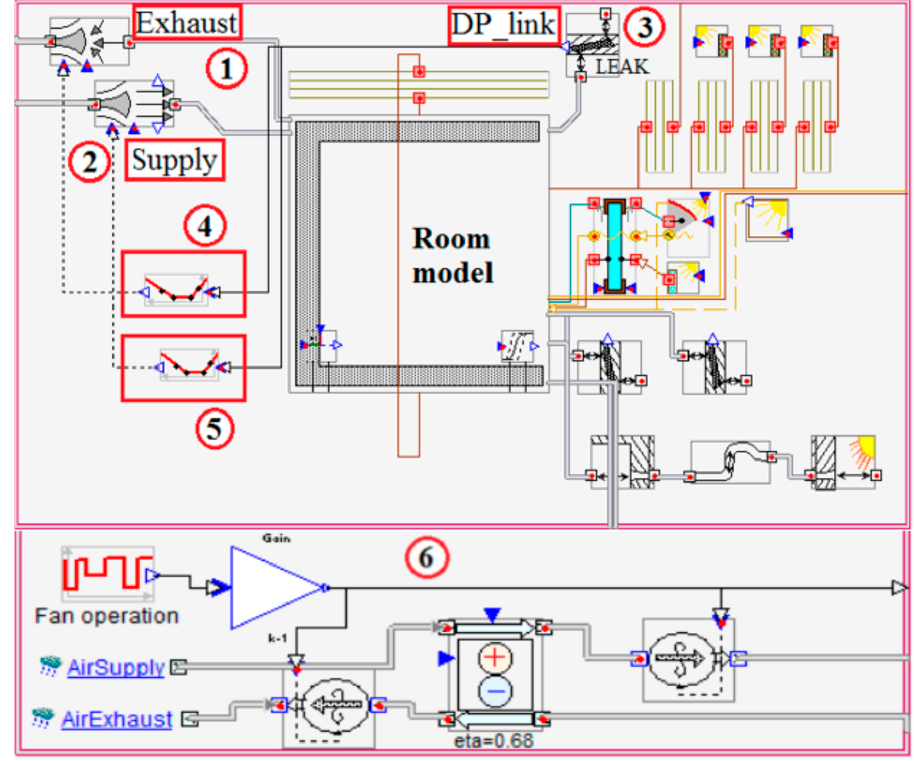
Figure 7. Schematics of the studied ventilation units modelling in IDA Indoor Climate and Energy (IDA ICE): (1) exhaust air terminal; (2) supply air terminal; (3) exterior wall leak module; (4) and (5) linear segment controllers; (6) ventilation unit module.